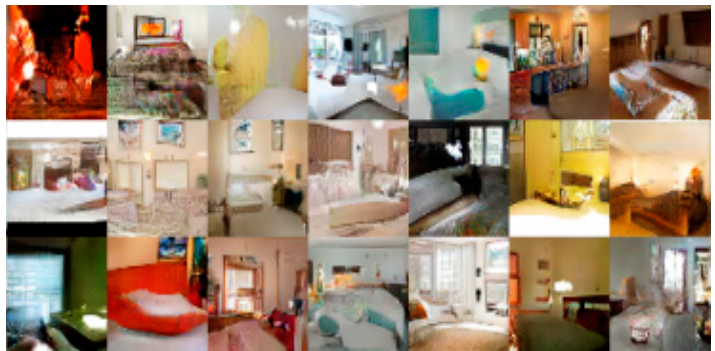
Figure 39. Experimental outputs of bedroom images.